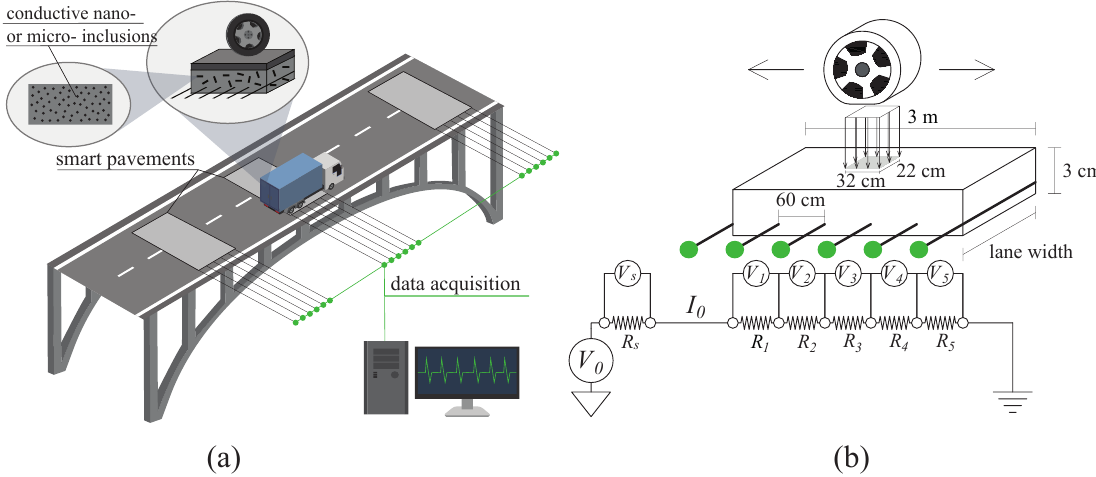
Figure 1. Smart pavement-based weigh-in-motion (WIM) system illustrating ( a ) the integrated smart pavement within the bridge system; and ( b ) the electrical